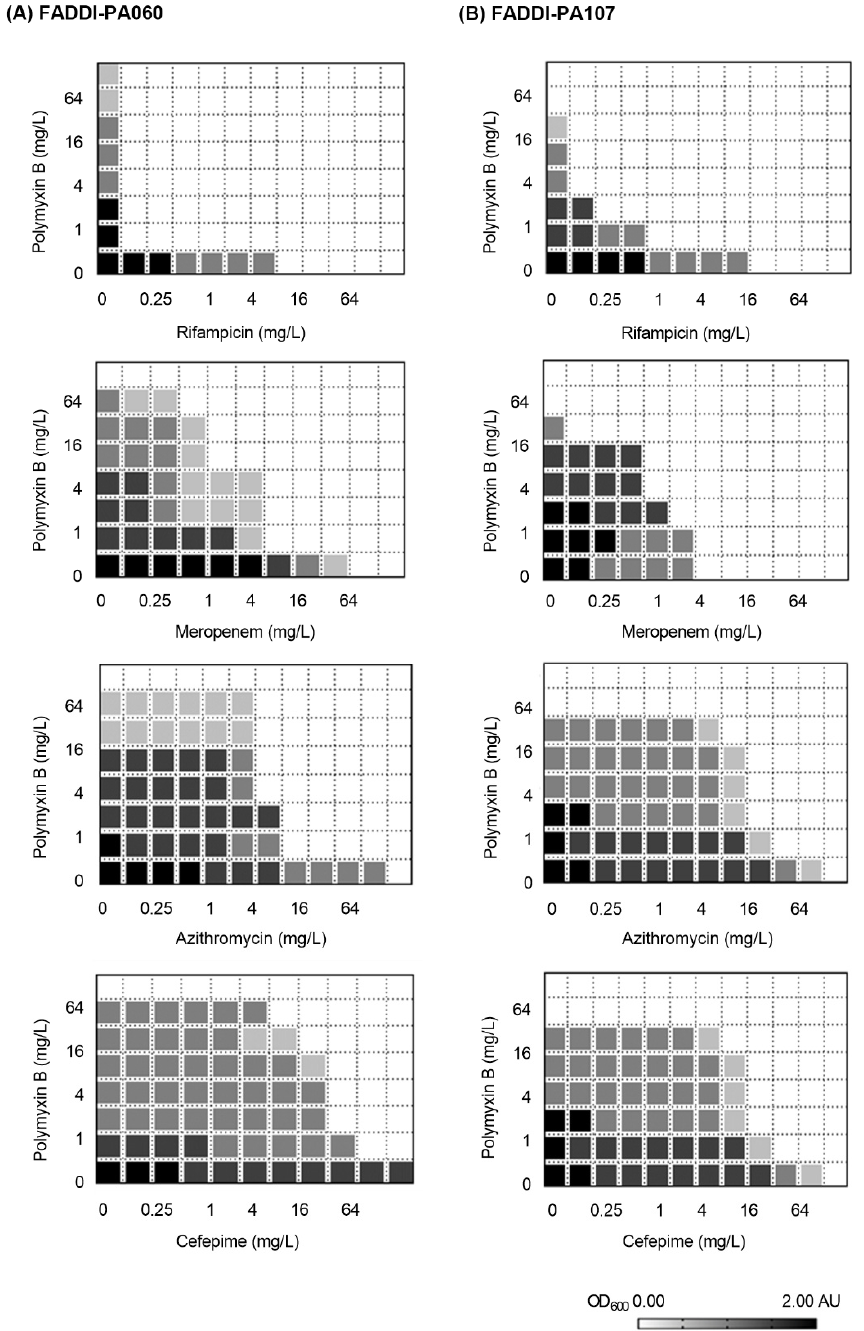
Figure 4. Checkerboard assay results of FADDI-PA060 ( A ) and FADDI-PA107 ( B ) examining polymyxin B in combination with a representative antibacterial agent from different antibacterial classes. Color gradient corresponds to the average turbidity at λ = 600 nm.